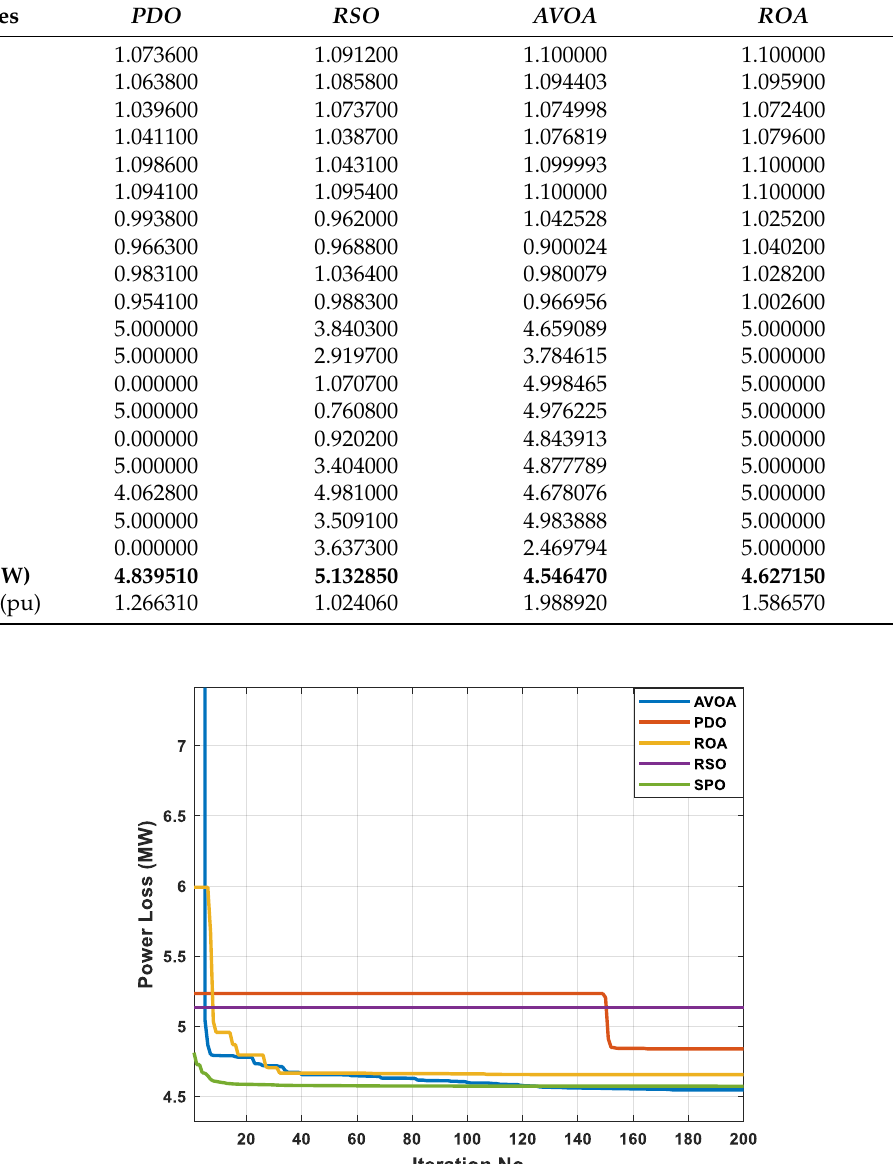
Figure 8. The AVOA voltage profile with the other compared methods for case 3. All proposed algorithms succeeded in saving real power losses and achieving real and reactive power balance as shown in Table 13. Also, statistical analysis is illustrated in Table 14. The performance evaluation of the proposed algorithms with a number of runs is 50. The AVOA algorithm ’ s narrow range between minimum and maximum values presents a minimum stander deviation value (0.042 pu). Additionally, it achieves a minimum mean value of computational time (16.00185 s) among other compared algorithms. Table 13. Balance of active and reactive power for proposed algorithms with case 3. 9